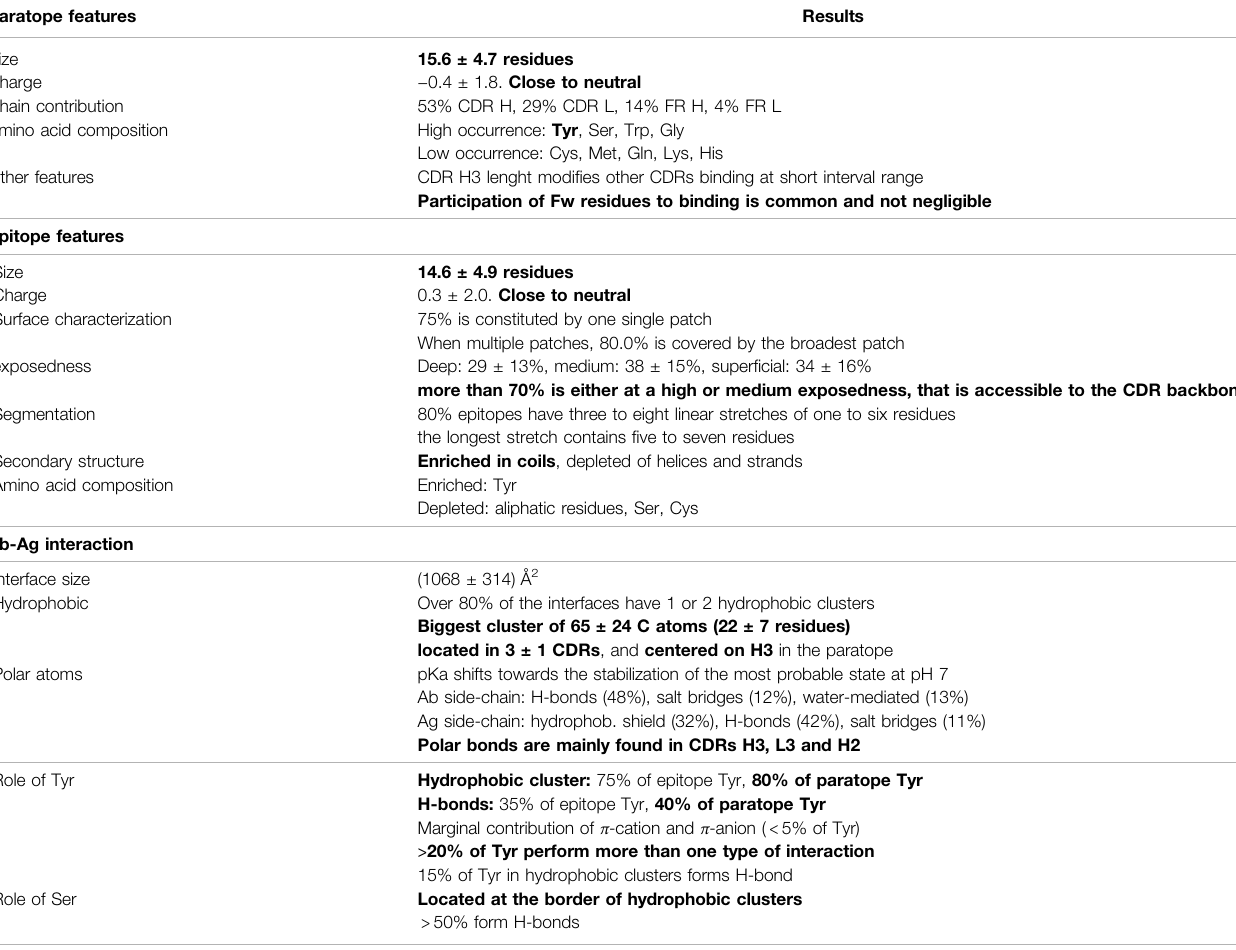
TABLE 1 | Summary of the Ab-Ag structural features (the most relevant, in Authors ’ opinion, are in bold). Paratope